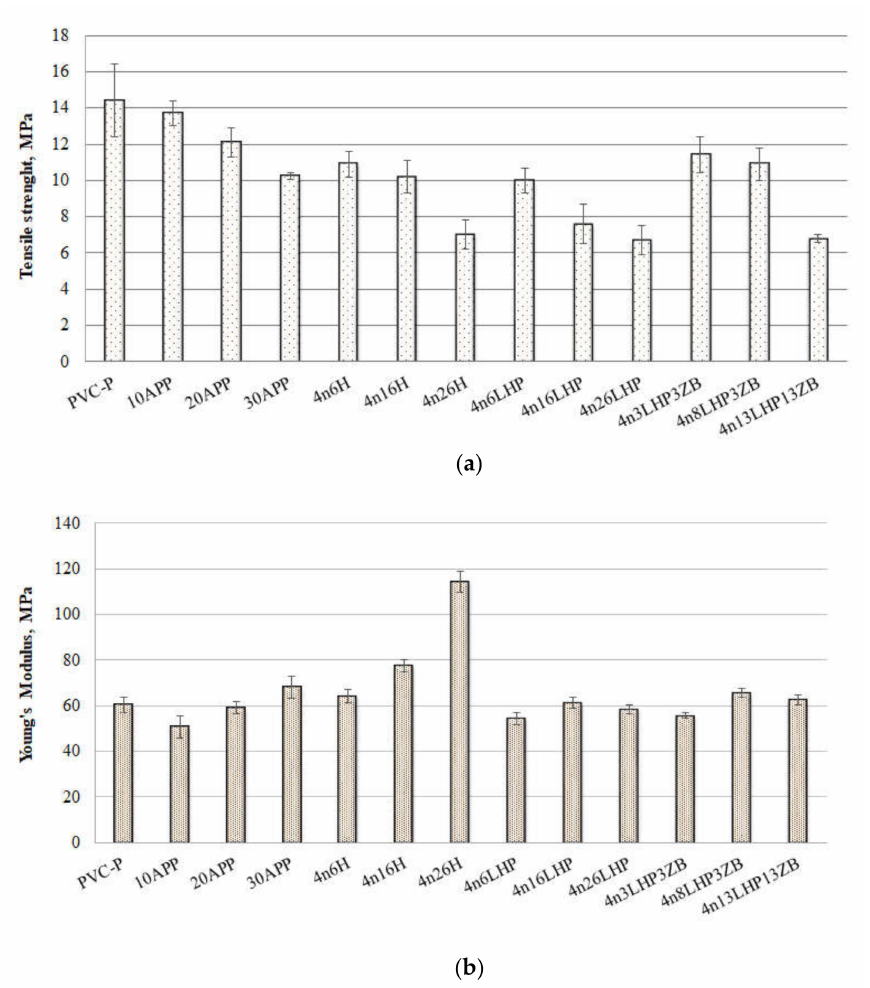
Figure 4. Tensile strength ( a ) and Young’s modulus ( b ) results of PVC/FRs obtained from tensile